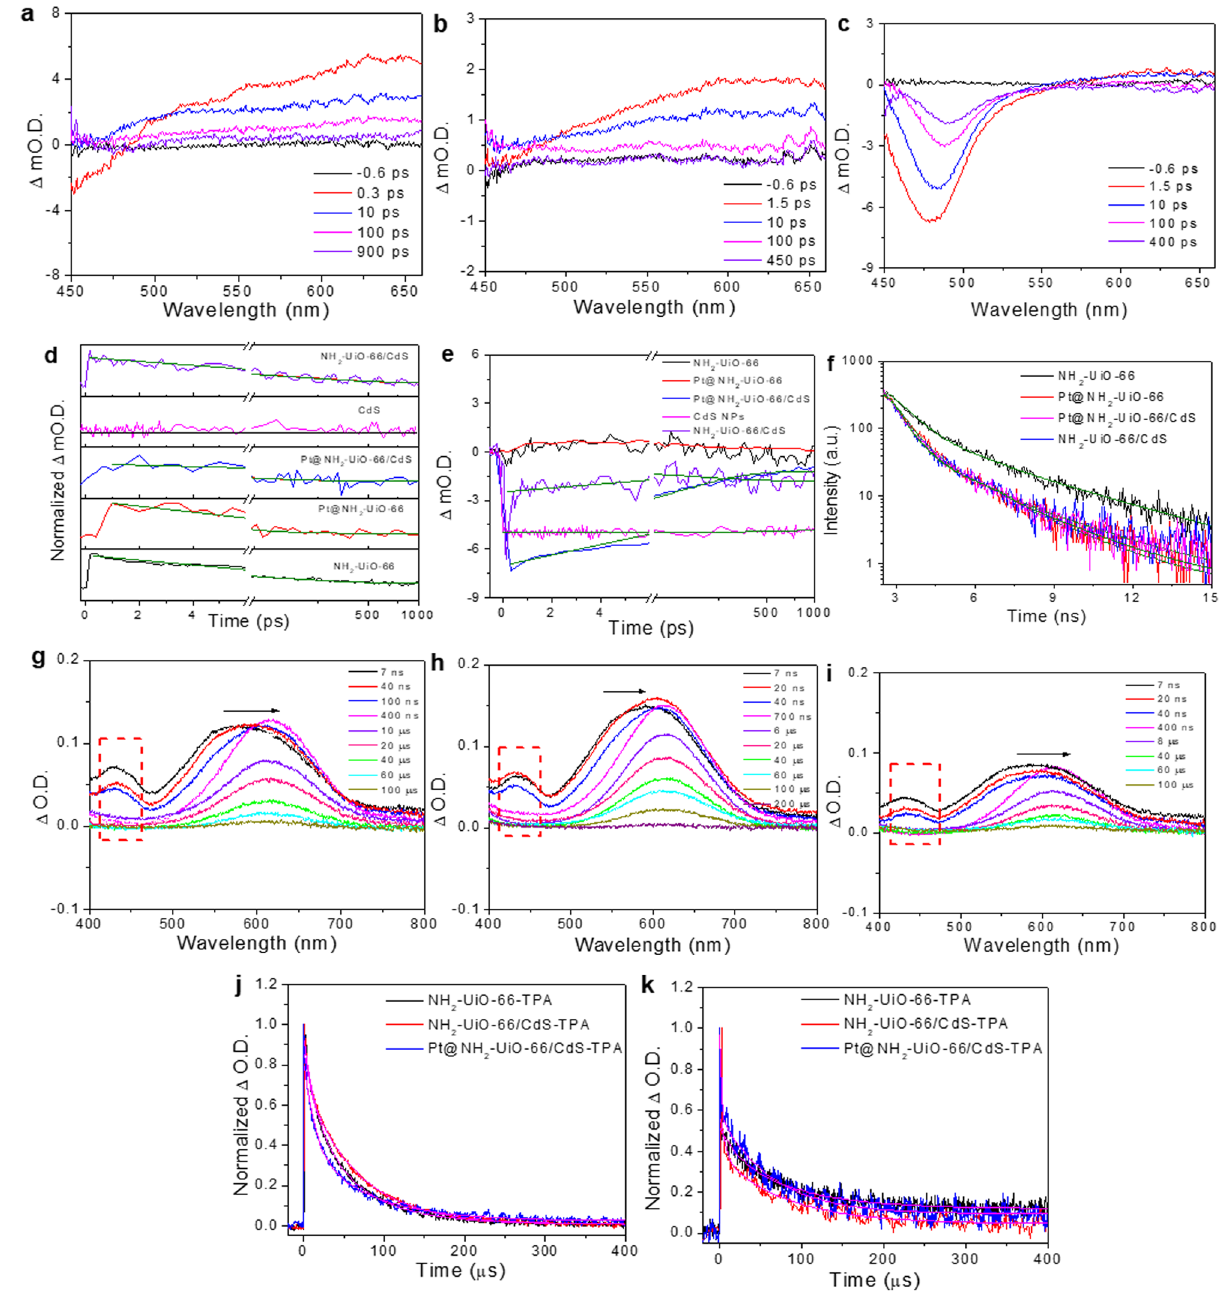
Fig. 3 Transient absorption spectra (TAS), kinetic pro fi les, and time-resolved photoluminescence (PL) spectra. a – c TAS of a NH 2 -UiO-66, ( b ) Pt@NH 2 - UiO-66, and ( c ) Pt@NH 2 -UiO-66/CdS with TA signal, given in optical density (OD) units, upon 400-nm laser excitation. d , e Kinetic pro fi les of NH 2 -UiO- 66, Pt@NH 2 -UiO-66, Pt@NH 2 -UiO-66/CdS, CdS NPs, and NH 2 -UiO-66/CdS at ( d ) 650 nm, and ( e ) 480 nm, respectively. f Time-resolved PL decay pro fi les for NH 2 -UiO-66, Pt@NH 2 -UiO-66, Pt@NH 2 -UiO-66/CdS and NH 2 -UiO-66/CdS, (400 nm excitation, 450 nm emission). All the olive lines are best fi ts with a biexponential function. g – i TAS of ( g ) NH 2 -UiO-66, ( h ) NH 2 -UiO-66/CdS, and ( i ) Pt@NH 2 -UiO-66/CdS with triphenylamine (TPA)